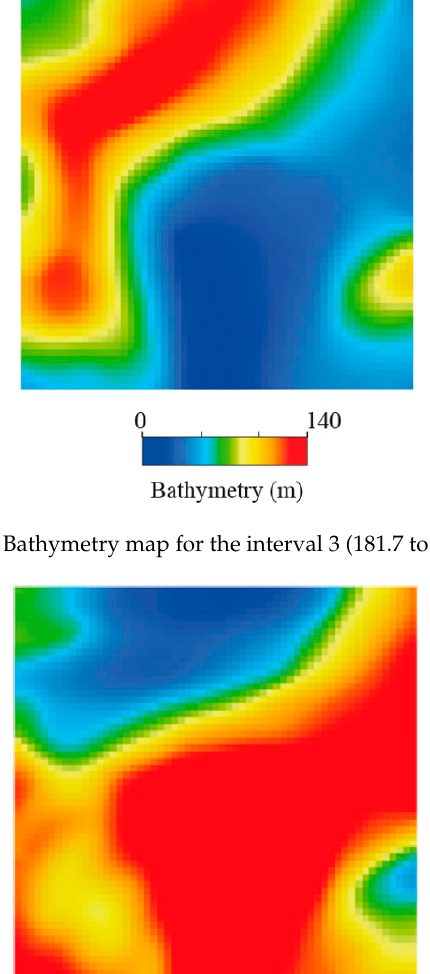
Figure 13. Slope map, relative effect of transport and domain of TOC distribution for the interval 3 (181.7 to 181.5 Ma).